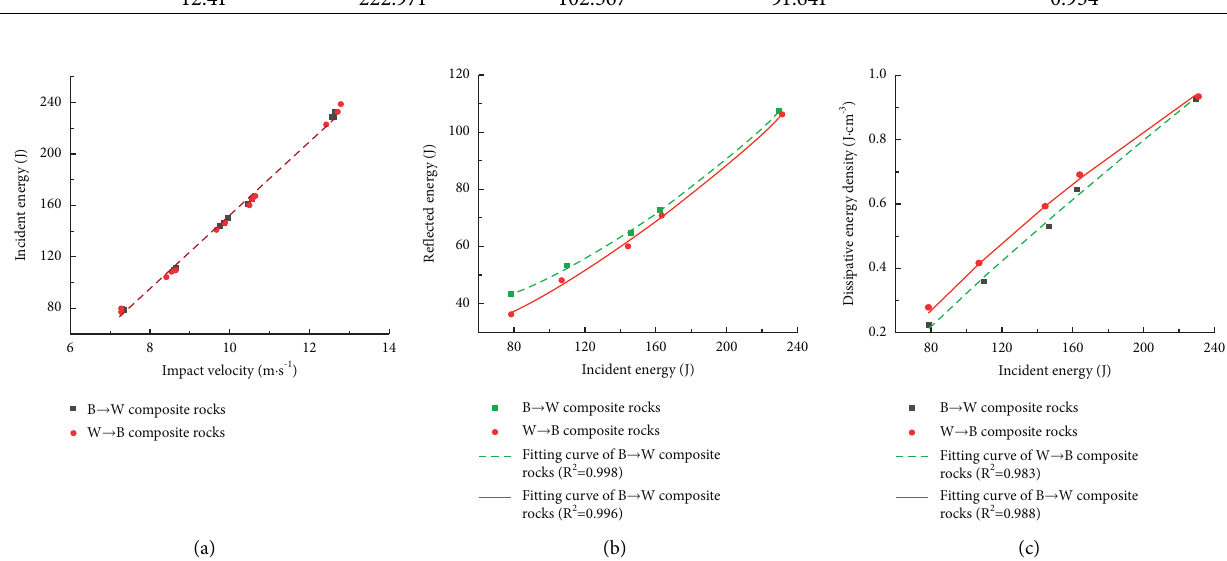
Figure 7: Energy evolution patterns of layered composite rock mass. (a) Impact velocity-incident energy. (b) Incident energy-reflected energy. (c) Incident energy and fragmentation energy